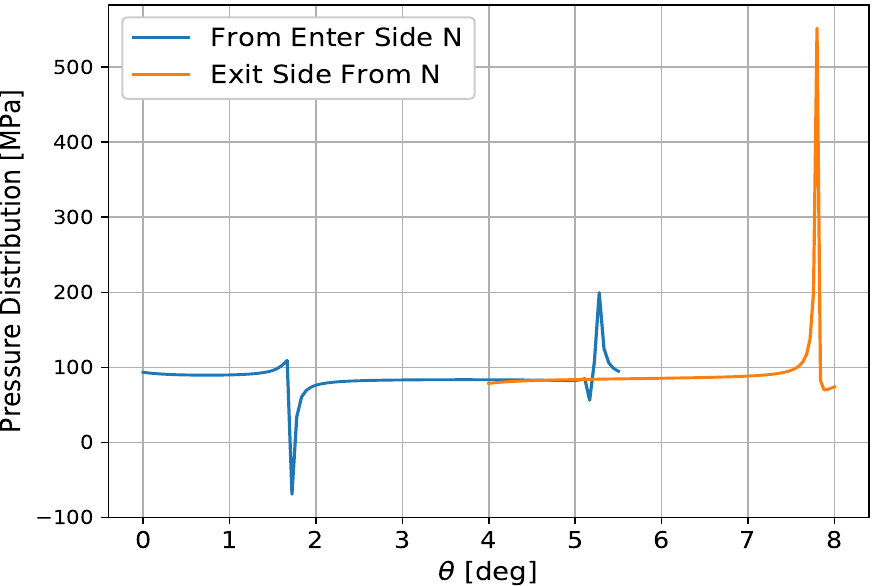
Figure 9. Pressure distribution phenomena under rolling contact from entry side and the exit side of the neutral point versus the bite angle